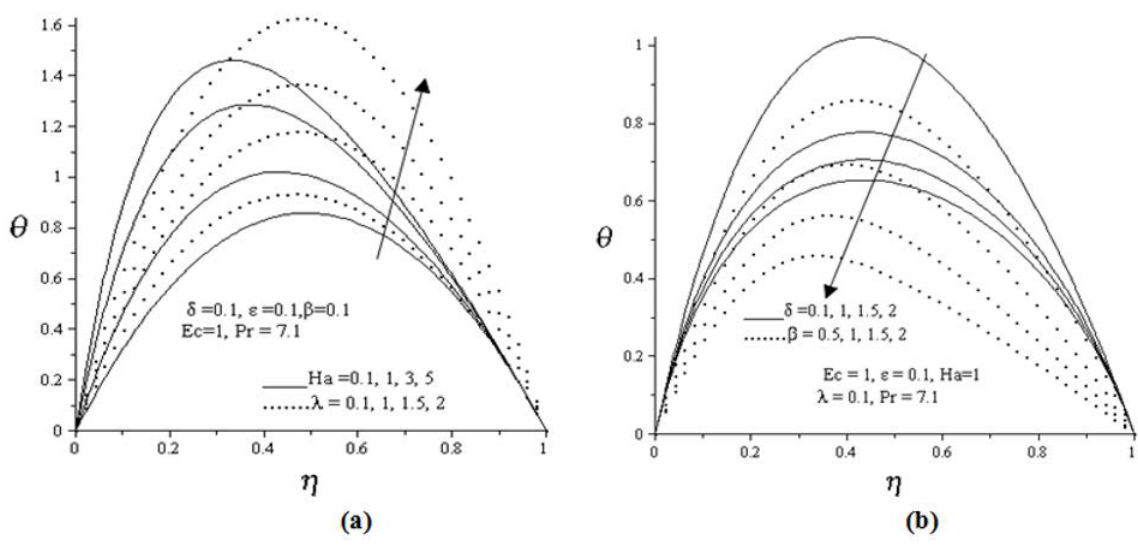
Figure 6. Steady state temperature profiles with increasing Ha , λ , β and δ .